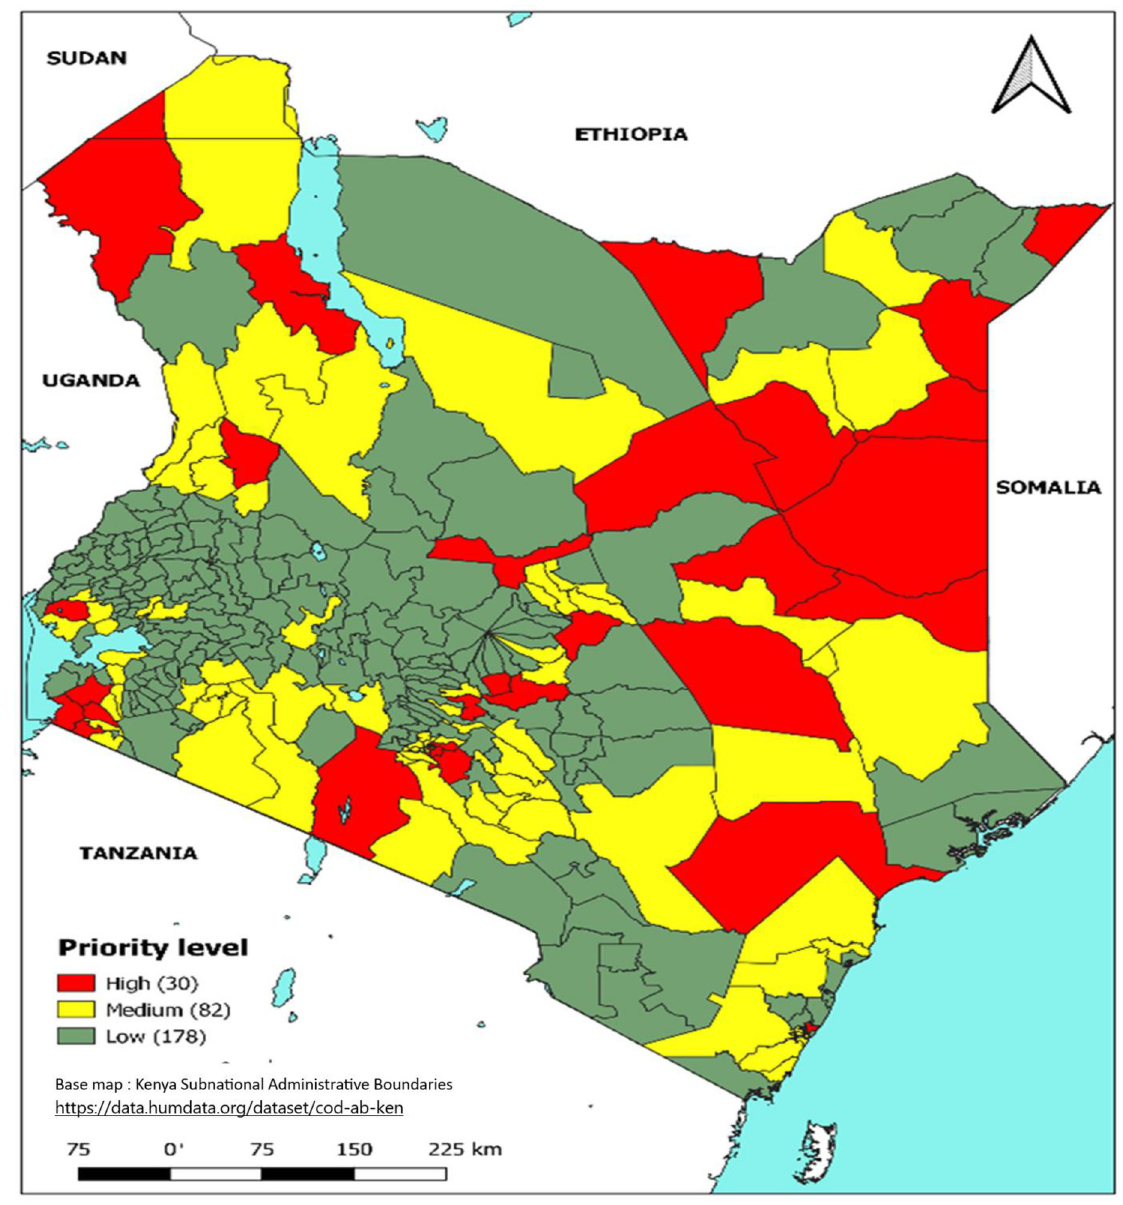
Fig 6. Priority sub-counties based on a combination of Epidemiological and WASH indicators, Kenya, 2015–2019. Link to base map layer: https://data.humdata.org/dataset/cod-ab-ken Link to terms of use: https://data.humdata.org/faqs/licenses.